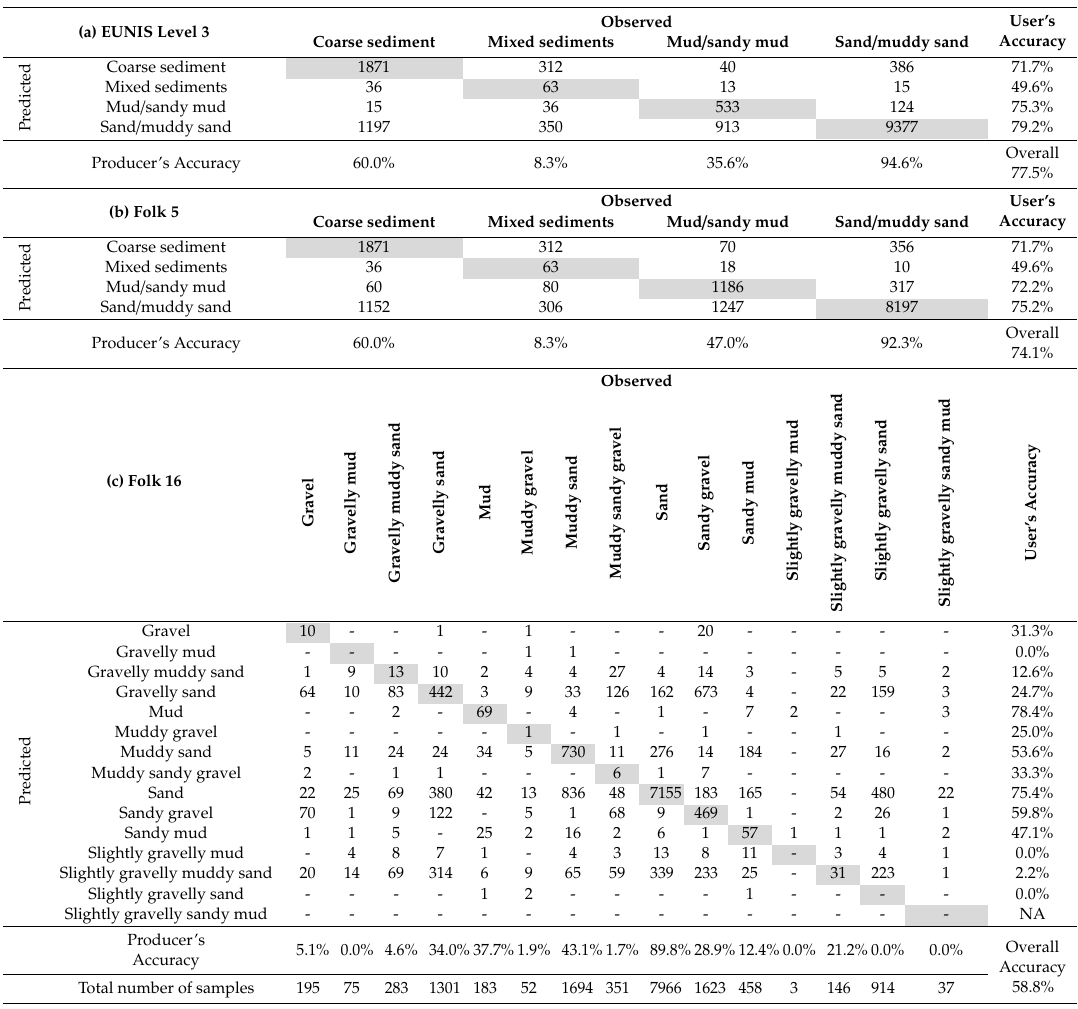
Table 3. Confusion matrices for the three classification schemes against the test sample set. ( a ) EUNIS level 3. ( b ) Folk 5. ( c ) Folk 16. Correctly classified samples are highlighted in